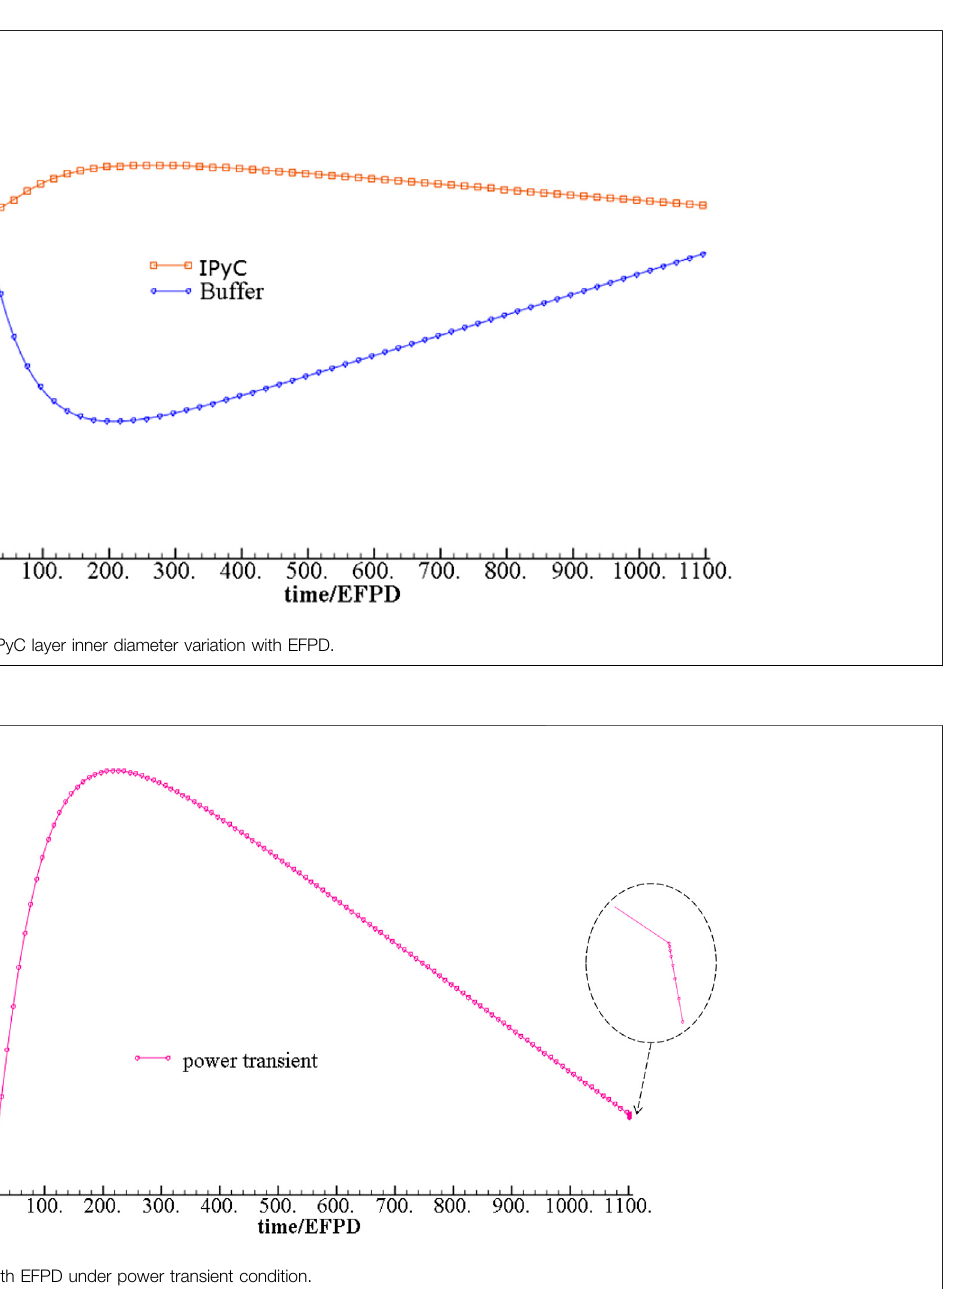
FIGURE 9 | Variation of gap distance with EFPD under power transient